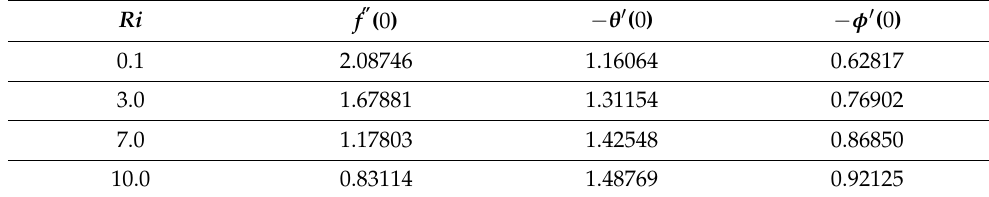
Table 3. Consequences of Ri on (a) f (cid:48)(cid:48) ( 0 ) (b) θ (cid:48) ( 0 ) (c) φ (cid:48) ( 0 ) when N = 0.5, β = 0.1, K = 0.1,